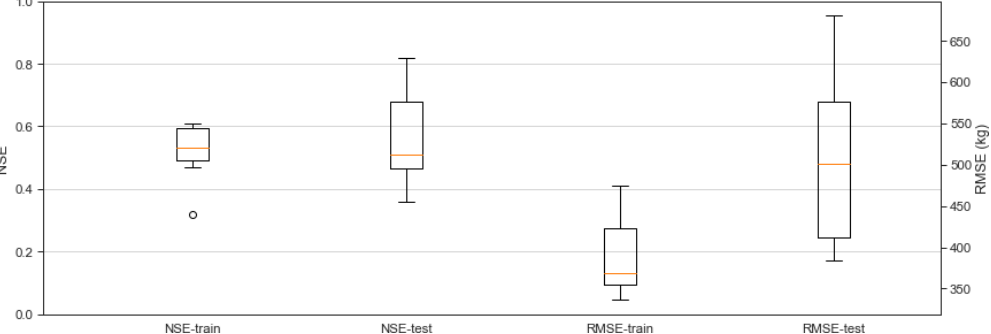
Figure 5. Boxplots of the performance metrics over the training and test sets using the monthly backward-chaining nested cross-validation.